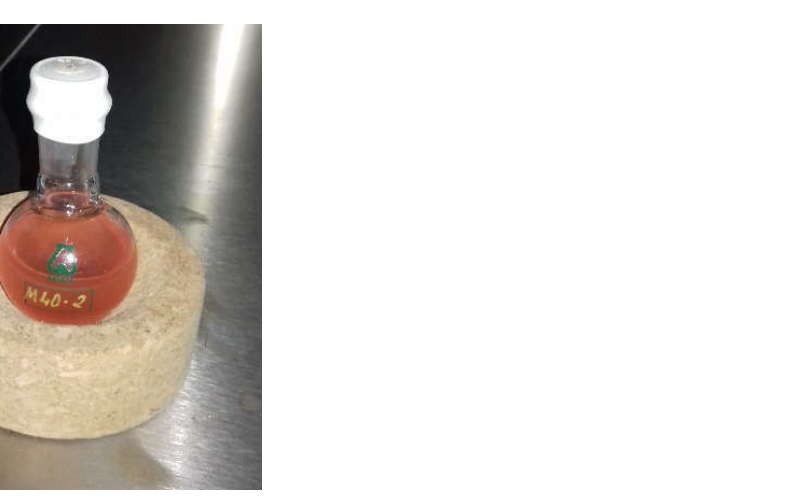
Figure 2. Photograph of the drug-loaded (10 wt.% Dox·HCl) polymersome